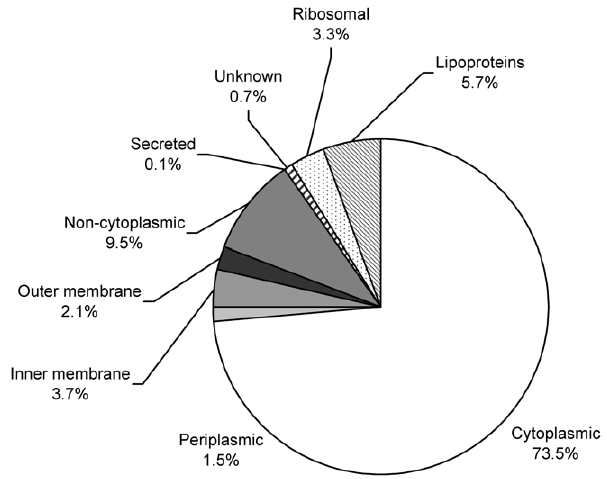
Figure 2. Percentage of leptospiral proteins identified in TX- 114 OMP enriched fractions according to